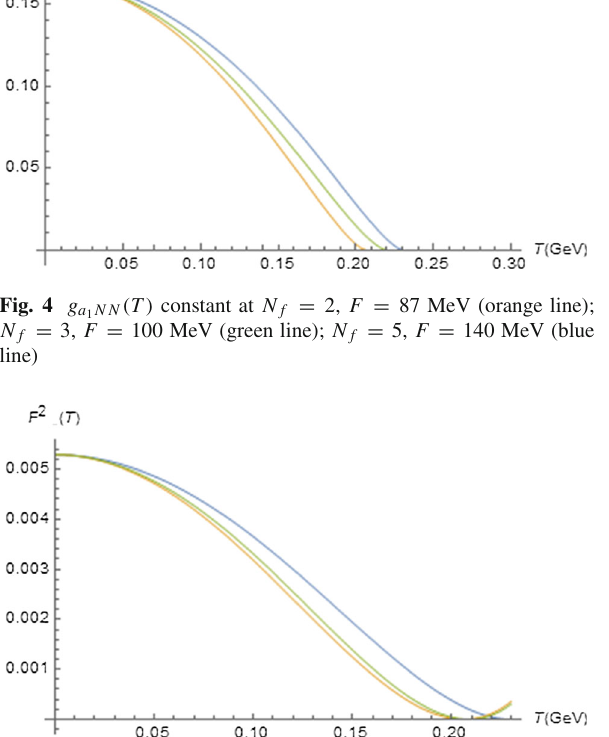
( T ) decayconstantat N = f 1